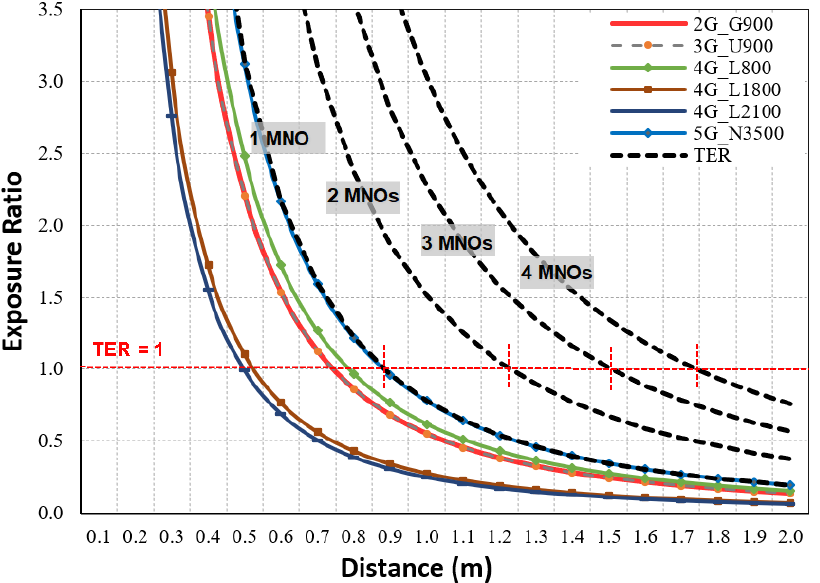
Figure 13. The exposure ratio at the main direction for multi-technology IBS site, referencing ICNIRP limits for GP.